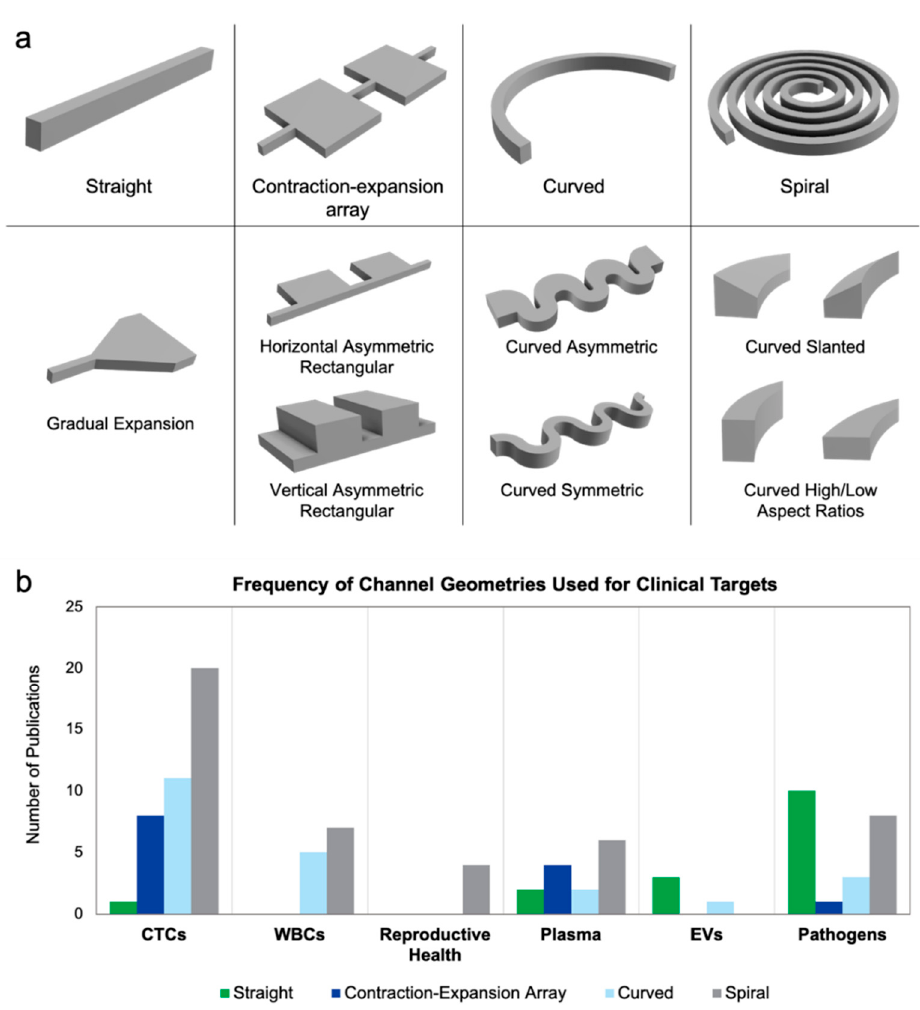
Figure 2. ( a ) Channel geometries frequently used in inertial microfluidics. Several variations of straight, contraction-expansion array, curved, and spiral geometries are used to manipulate particles into different streamlines. ( b ) Summary of channel geometries used for the analysis of clinical targets investigated in this review. Targets investigated are white blood cells (WBCs), circulating tumor cells (CTCs), reproductive health-related particles, extracellular vesicles (EVs), blood plasma, and pathogens.